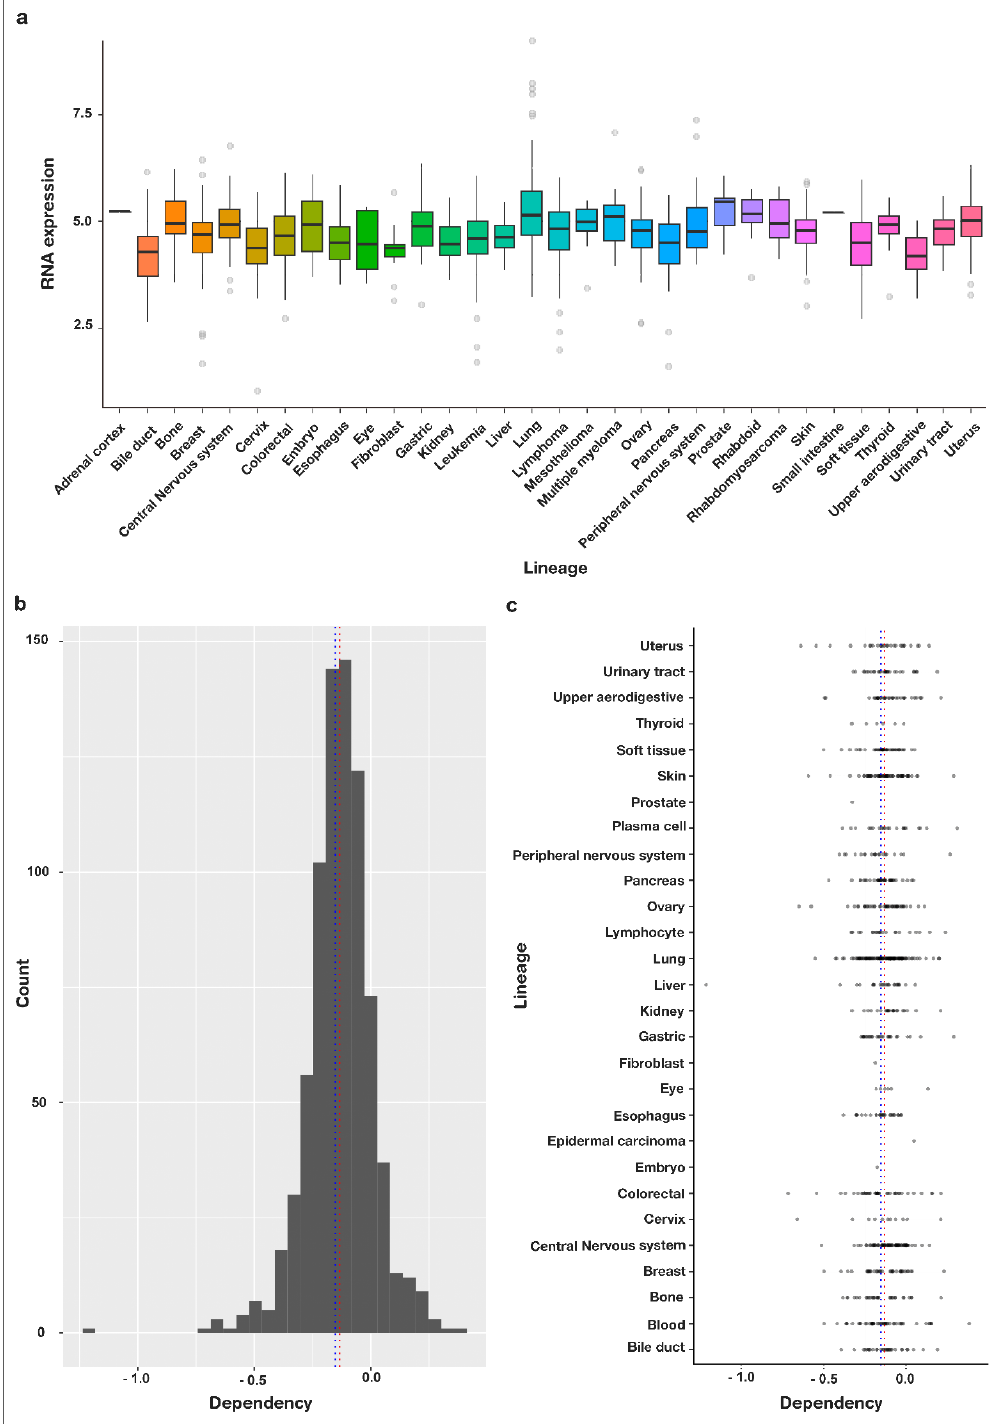
Figure 1. SALL4 is an essential gene for survival of cancer cells. ( a ) Expression pattern of SALL4 across different cancer types. ( b ) The dependency score − 0.13325 was calculating by getting average from dependency score of 789 different cell lines for SALL4 (the score determines the importance of the gene for survival of cancer cells and how its elimination is lethal for the cells). ( c ) Categorization of different cell types based on the tissue of origin shows that almost all cancer types have a negative dependency score for SALL4 meaning that they are vulnerable to omission of